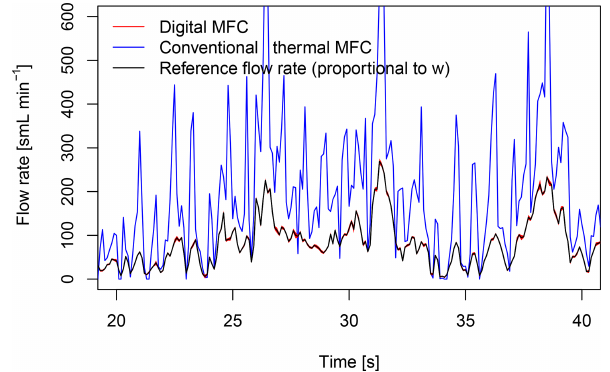
Figure 9. Mass flow rate readings of a conventional thermal mass flow controller (Vögtlin red-y smart series), in blue, measuring a dynamically changing reference flow (black). The magnitude of the reference flow rate, which is proportional to the magnitude of recorded vertical wind velocity data, varied at a frequency of 10Hz. The reference flow (black) was generated using the new digital mass flow controller. The uncertainty range of the digital mass flow con- troller (red) is small. Conversely, the mass flow reading of the con- ventional thermal mass flow controller deviates significantly from the reference as the conventional mass flow controller is unable to follow the highly dynamic reference signal.